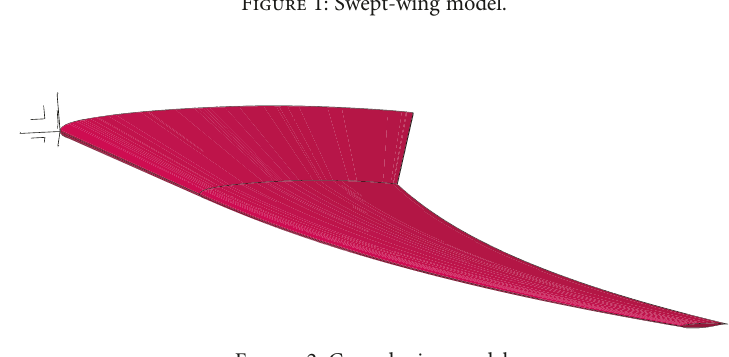
Figure 2: Curved-wing model.